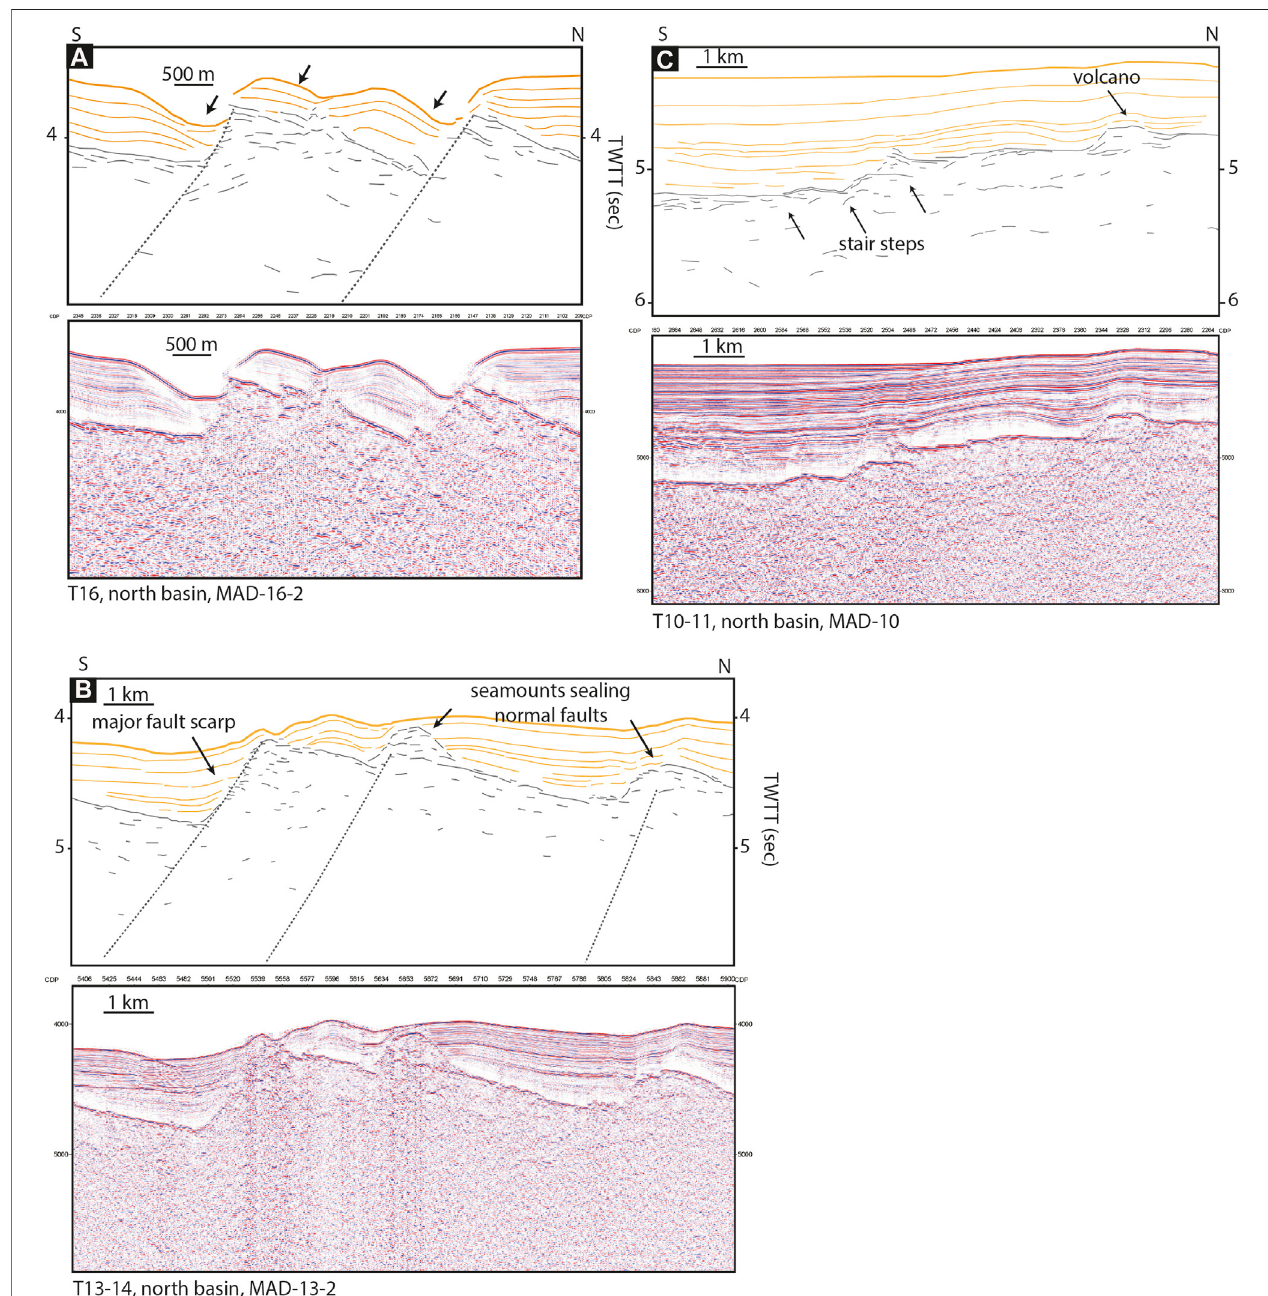
FIGURE 9 | (A) Example of currents-related sedimentary architectures associated with normal faults affecting the basement in the young oceanic domain. (B) Example of top basement morphology in the young oceanic domain. Note the presence of rounded seamounts sealing several fault breakaways. (C) Details of the top basement morphology in the smooth and regular basement subdomain, along the transect T10 – 11, north basin. Stair steps buildings and presence of a rounded seamount. Location of the close-up views is shown in Figure 6 .